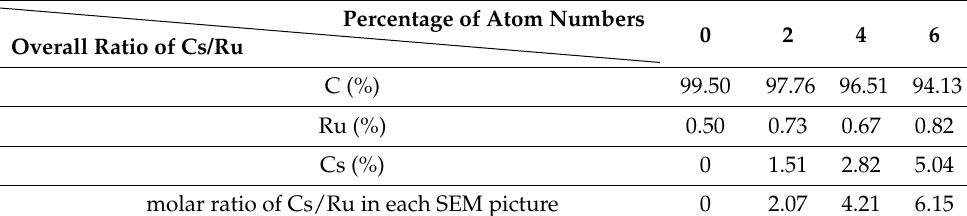
Table 1. The percentage of atom numbers for each element of C, Ru, and Cs in SEM pictures. Percentage of Atom Overall Ratio of Cs/Ru